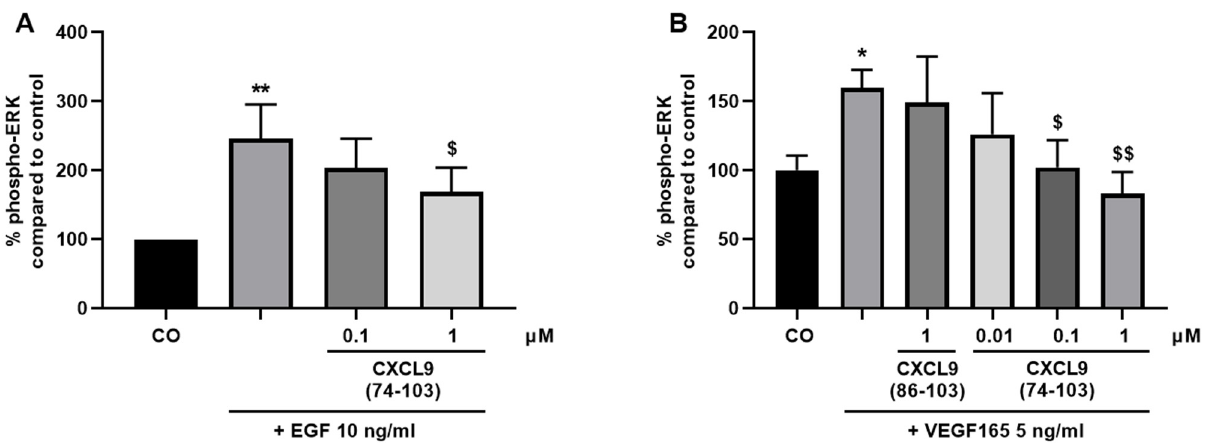
Figure 6. CXCL9(74-103) reduces EGF- and VEGF165-induced activation of pERK in endothelial cells. ( A ) HMVECs or ( B ) MECs were stimulated with ( A ) 10 ng/mL EGF or ( B ) 5 ng/mL murine VEGF165 as a single stimulus or with varying concentrations of CXCL9(86-103) or CXCL9(74-103) for ( A ) 15, or ( B ) 5 min, respectively. The amount of phosphorylated ERK to total protein was determined. Results are expressed as a mean ( ± SEM) percentage of phospho-ERK compared to the control (100%). [n ≥ 3; Mann–Whitney U test; * p < 0.05, ** p < 0.01 (compared to control); $ p < 0.05, $$ p < 0.01 (compared to growth factor)].